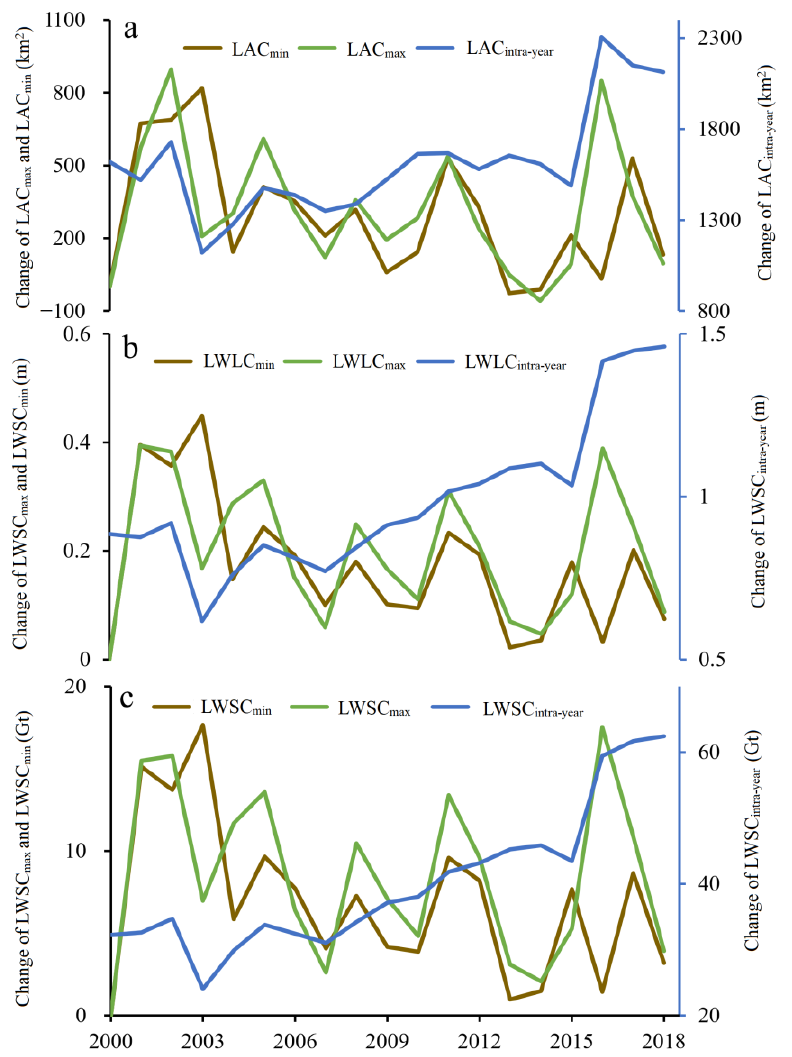
Figure 3. Lake changes on the TP from 2000 to 2018: ( a ) lake area changes; ( b ) the average of LWLC; ( c ) the LWSC.